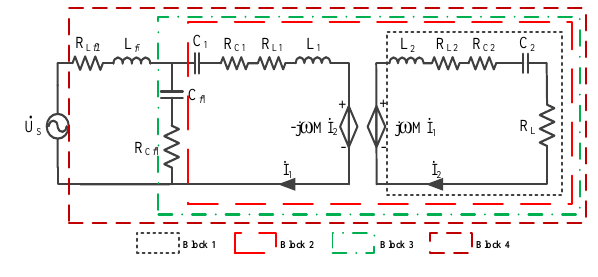
Figure 2. The equivalent circuit with ESRs.